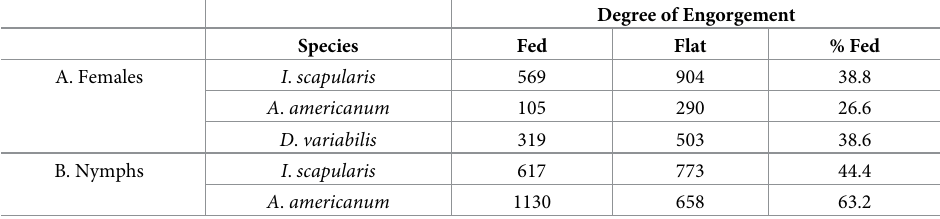
Table 4. Degree of engorgement (fed vs. flat) of submitted ticks removed from human hosts.